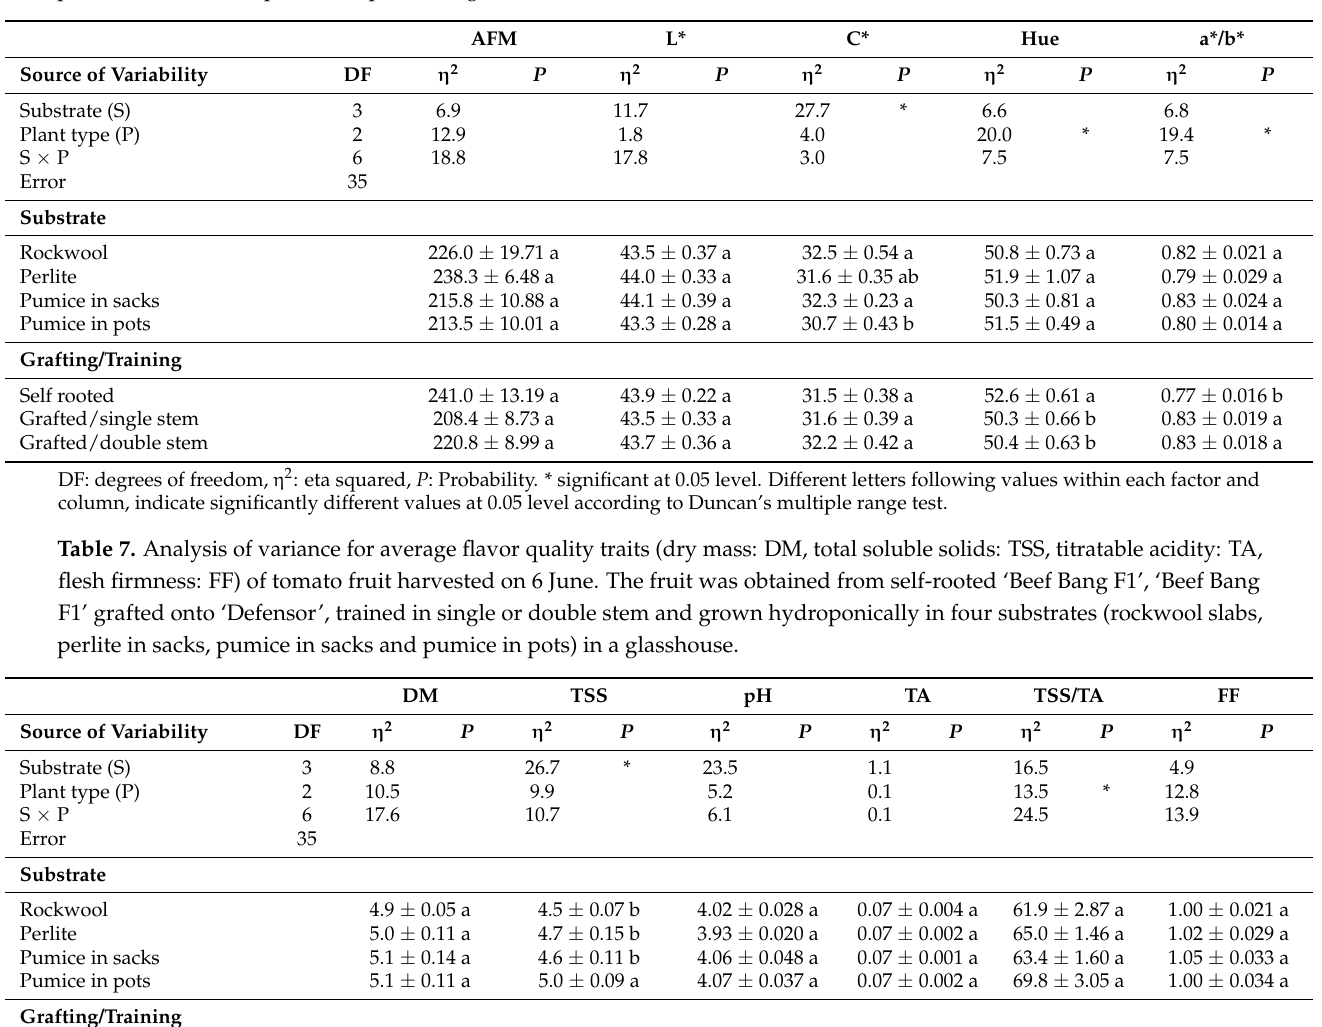
Table 6. Analysis of variance for average visual quality traits (fruit mass: AFM, luminance: L*, chroma: C*, hue, a*/b*) of tomato fruit harvested on 6 November. The fruit was obtained from self-rooted ‘Beef Bang F1’, ‘Beef Bang F1’ grafted onto ‘Defensor’, trained in single or double stem and grown hydroponically in four substrates (rockwool slabs, perlite in sacks, pumice in sacks and pumice in pots) in a glasshouse.